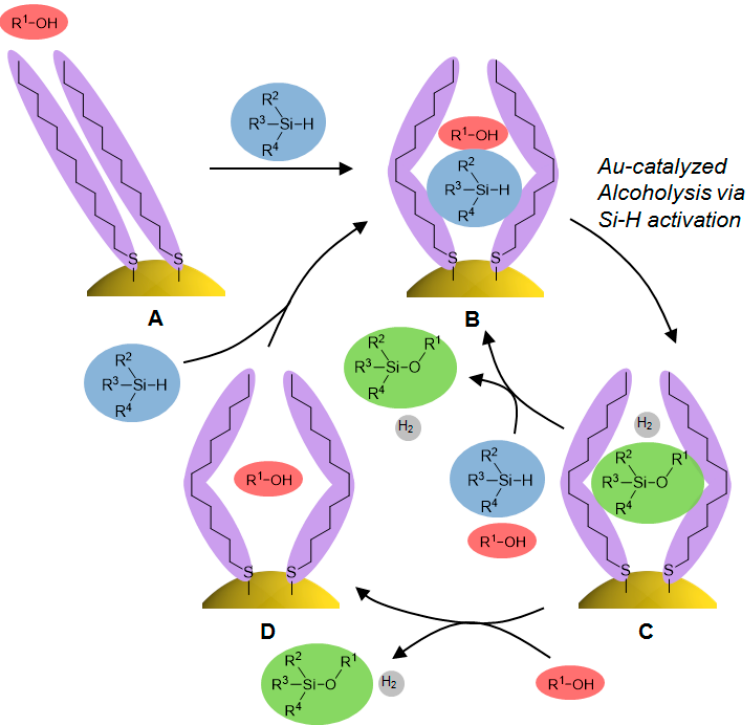
Figure 10. Proposed mechanism of catalytic alcoholysis of hydrosilanes over SAM-functionalized AuNPs.